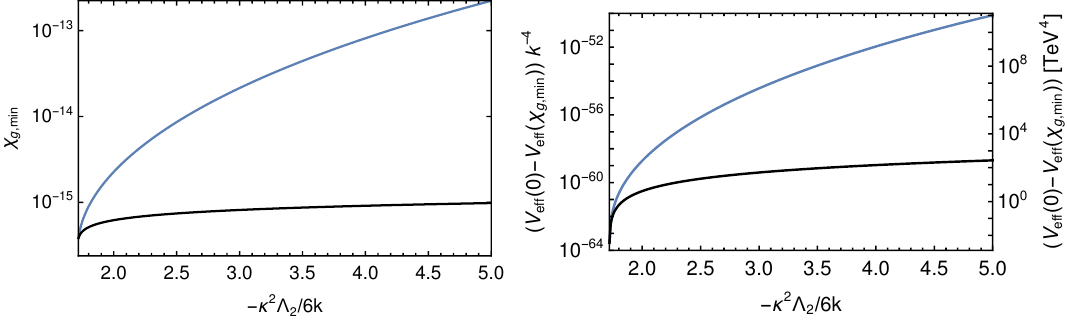
Figure 9 . Superpotential approximation. The choice of parameters is (cid:20) = 0 : 5 k (cid:0) 3 = 2 , (cid:13) = 0 : 1 k (cid:0) 3 = 2 , v 1 = (cid:0) 15 k 3 = 2 and v 2 = (cid:0) 3 : 3 k 3 = 2 . For these parameters, (cid:20) 2 (cid:3) (cid:3) = 6 k = (cid:0) 1 : 719 and k = 1 : 91 (cid:2) 2 10 15 TeV (2.27). On the left, we plot the value of (cid:31) g; min as function of (cid:3) 2 < (cid:3) (cid:3) . On the right, we 2 plot the di(cid:11)erence between the minimum of the potential and the origin, V e(cid:11) (0) (cid:0) V e(cid:11) ( (cid:31) g; min ) as function of (cid:3) 2 < (cid:3) (cid:3) . In both cases, the blue line is the exact calculation and the black line the 2 approximate calculation keeping only orders O ( s